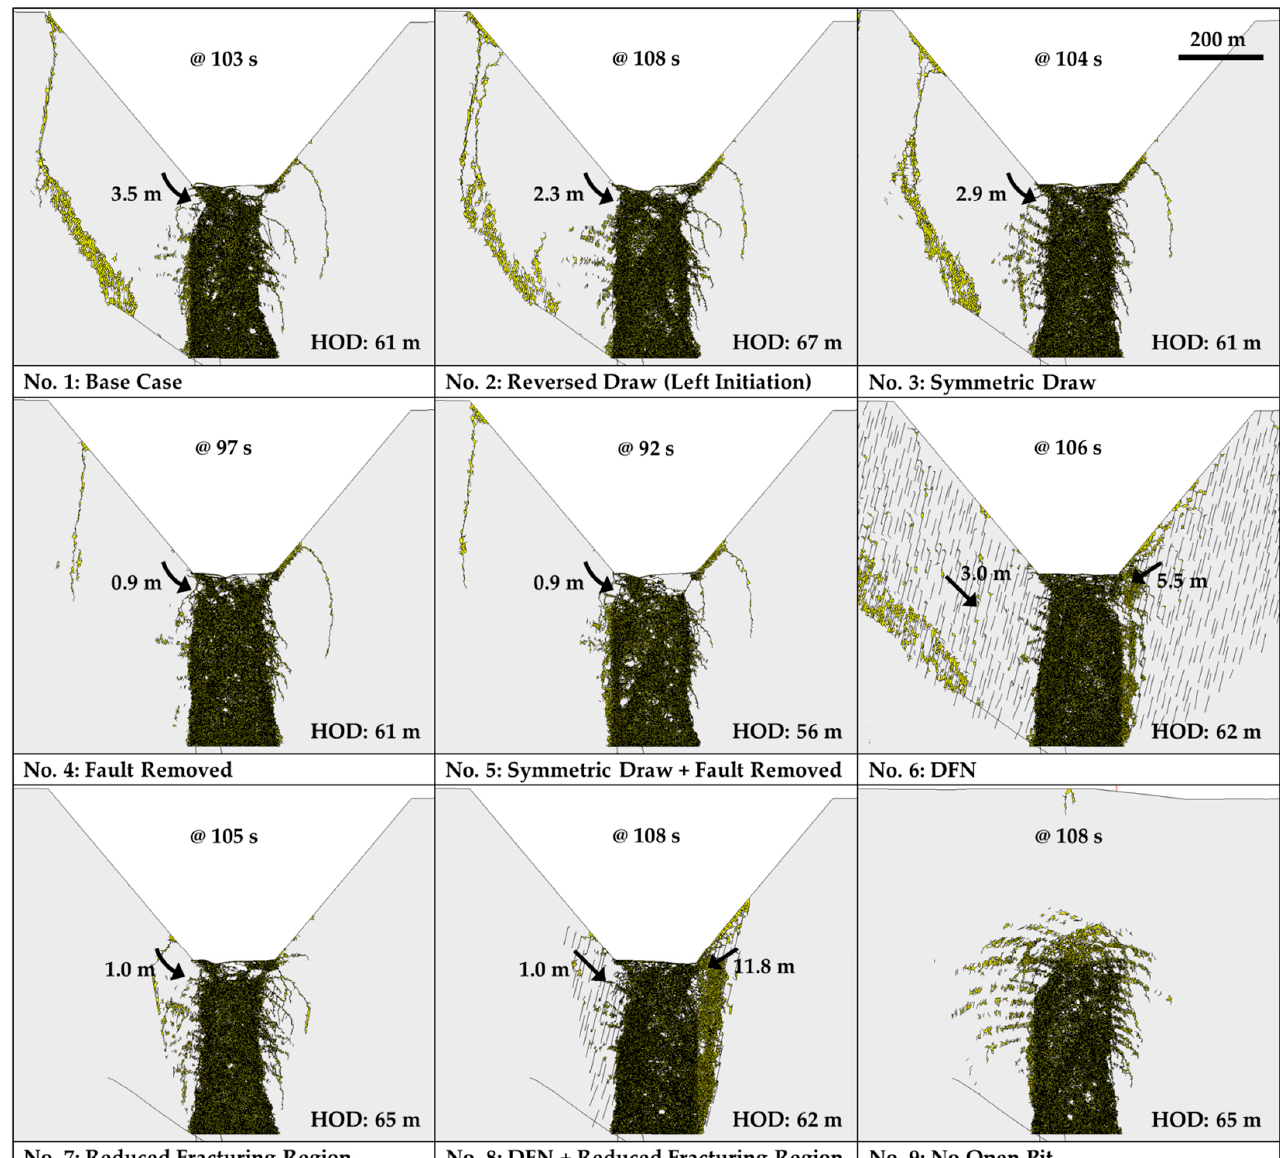
Figure 13. FDEM model results after 8900 m 2 ± 1% material removed. Maximum XY displacement at the toe of the pit slopes, maximum Y displacement representing height of draw (HOD), and model times past first deletion are reported for each model.